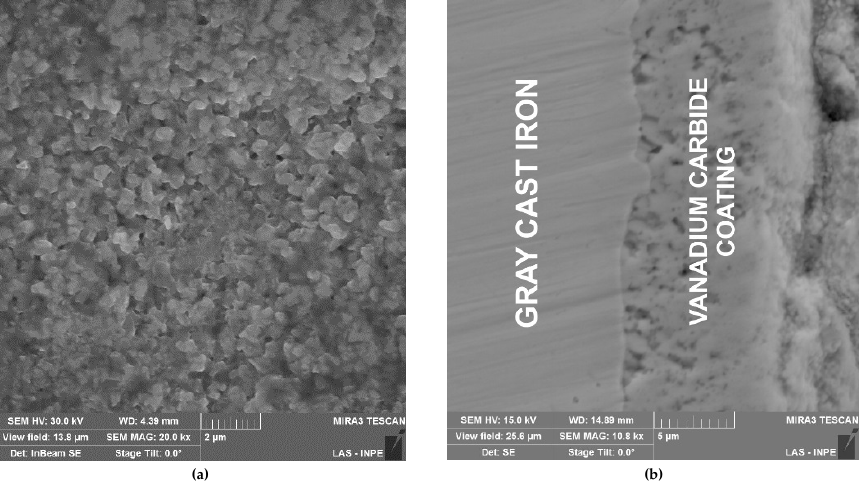
Figure 1. SEM micrograph: ( a ) Surface of vanadium carbide 20,000 × and ( b ) a cross section of coating 10,800 ×